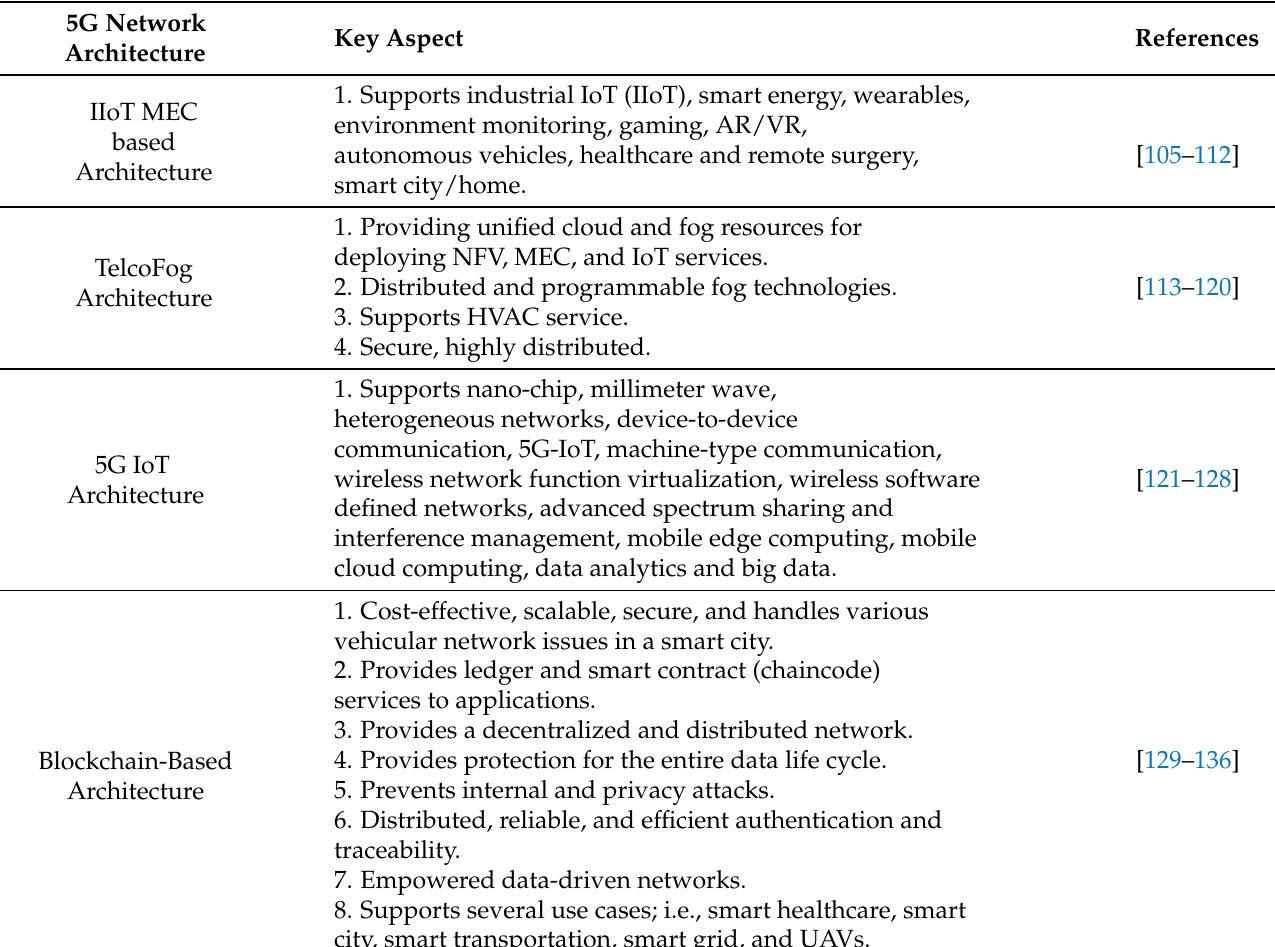
Table 3. Summary of studies on 5G network